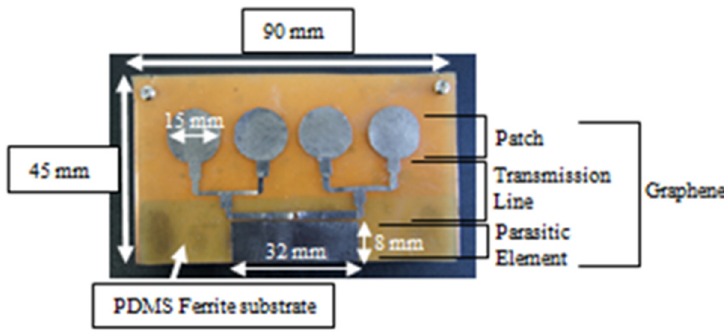
Figure 3. The synthesized Magnetite PDMS Graphene Array Figure 2. Processing steps for synthesizing the Magnetite PDMS Graphene Array Sensor.